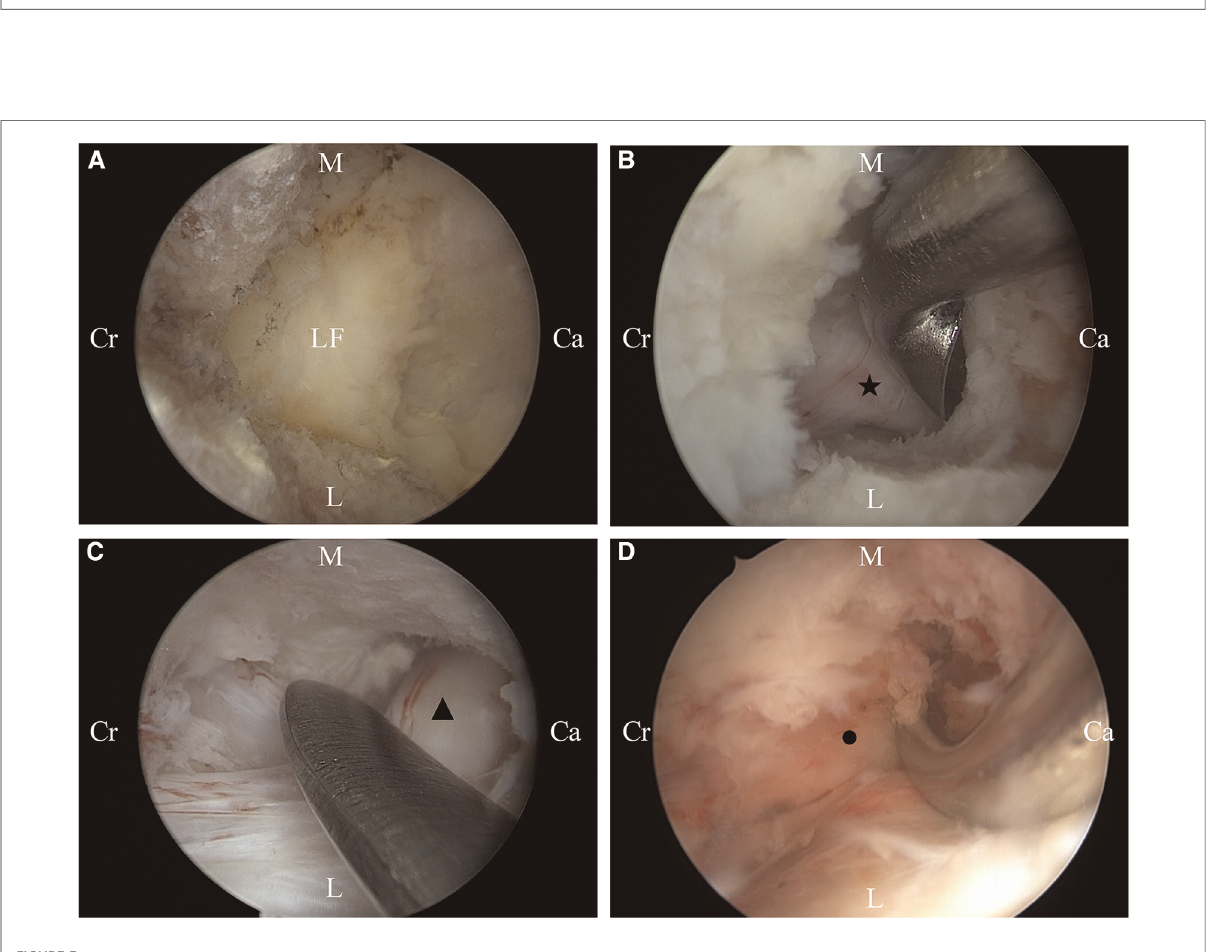
FIGURE 3 Intraoperative conditions of unilateral biportal endoscopy for decompression. ( A ) Initial camp; ( B ) Decompression of the ipsilateral traversing nerve root; ( C ) Decompression of the contralateral traversing nerve root; ( D ) Decompression of the contralateral foraminal. Ca, caudal sides; Cr, cranial sides; L, lateral; M, medial. LF, ipsilateral traversing nerve root; ▴ , contralateral traversing nerve root; ● , contralateral exiting nerve